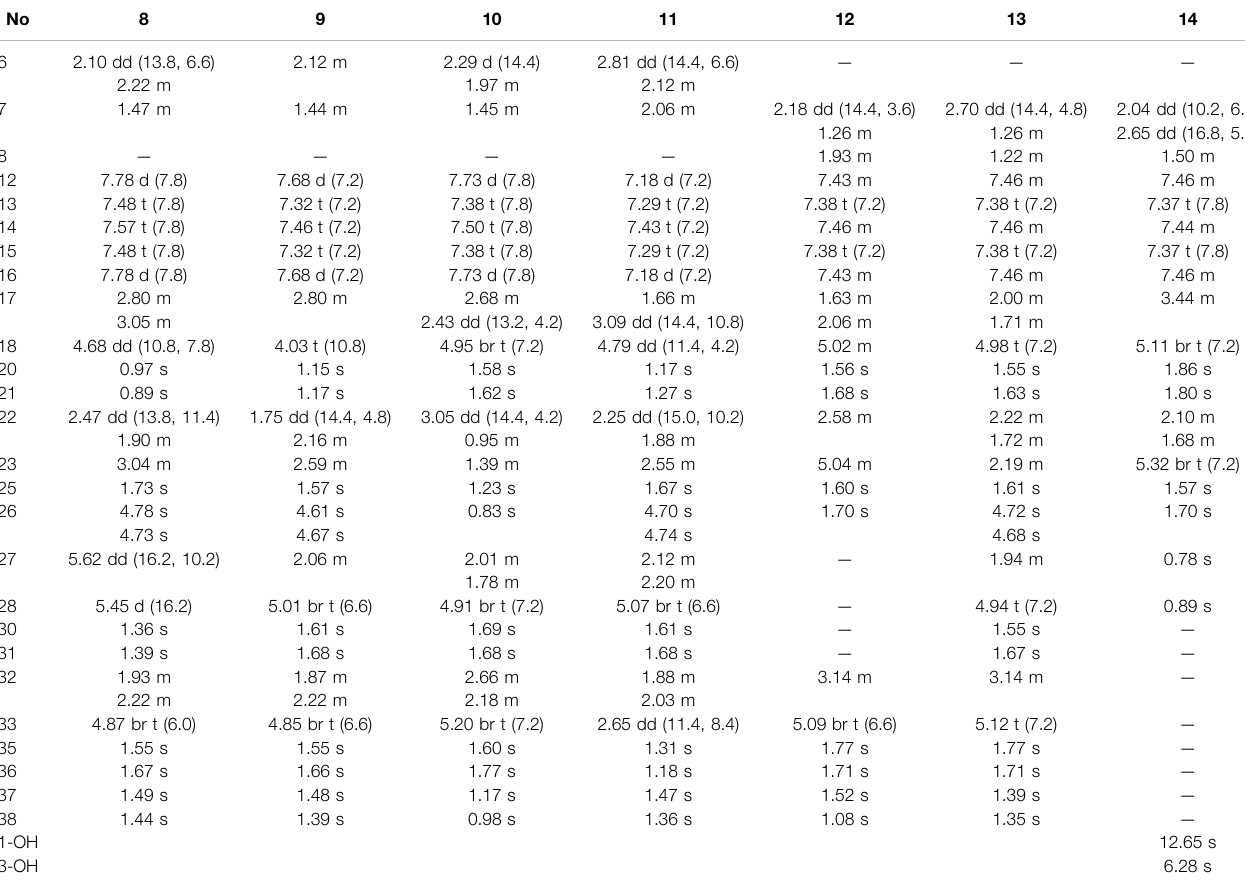
TABLE 3 | 1 H NMR data of compounds 8 – 14 in CDCl 3 (600 MHz, δ in ppm, J in Hz).